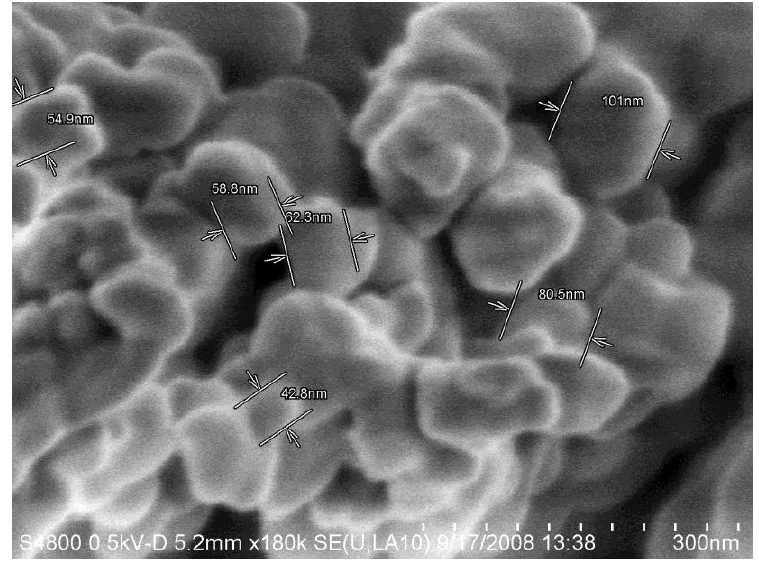
Figure 4. Severe degree of agglomeration of nanoparticles that renders definition of particle morphology and size very difficult. Quantitative analysis in MRI relies on measurement of nanoparticle size and magnetic